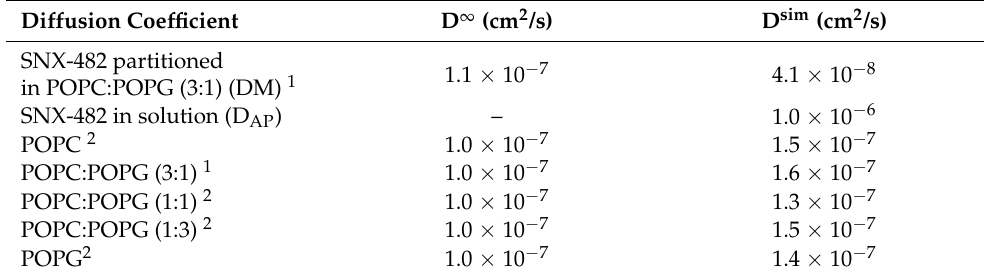
Table 3. Diffusion coefficients for unbound and bound